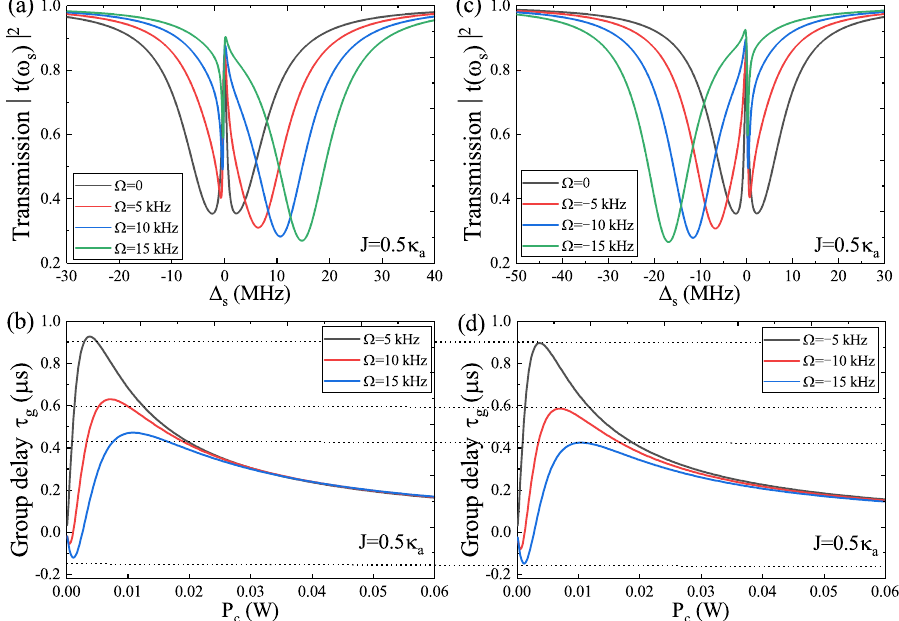
Figure 3. ( a , b ) The transmission T ( ω s ) and the group delay τ g for different angular velocities Ω rotating along the CW direction ( Ω > 0) at J = 0.5 κ a . ( c , d ) The transmission T ( ω s ) and the group delay τ g for different angular velocities Ω rotating along the CCW direction ( Ω < 0) at J = 0.5 κ a . On the other hand, the transmission spectra T ( ω s ) versus ∆ s with increasing cavity– cavity coupling J from J = 0.5 κ a to J = 2.0 κ a are also investigated under the WGM resonator a spinning along the CW ( Ω = 10 kHz) and CCW ( Ω = − 10 kHz) direction, respectively, as shown in Figure 4a,c. When the auxiliary optical cavity c is taken into consideration, the photons in cavity c will flow into WGM resonator a , which results in broader transmission spectra. Accompanying the WGM resonator a spinning along the CW and CCW direction, the transmission spectra present a right shift and left shift, respectively. In Figure 4b,d, we plot the group delay τ g for several different values of cavity–cavity coupling J under the resonator a spinning along ( Ω = 10 kHz) and CCW ( Ω = − 10 kHz) directions, respectively. Obviously, for the unchanged angular velocities Ω = 10 kHz and Ω = − 10 kHz, in the case of J = 0.5 κ a , the group delay τ g first reduces to a minimum value and then continuously increases until reaching a maximum value and finally decreases to a saturated value. Thus, the rotation along the CW direction of the resonator a induces greater slow light and the CCW rotation of the resonator a leads to an enhanced fast light effect. When J (cid:62) 1.0 κ a , the group delay τ g only manifests the slow light, and the slow light effect is larger in the situation of the resonator a rotating in the CW direction than in the condition of the CCW